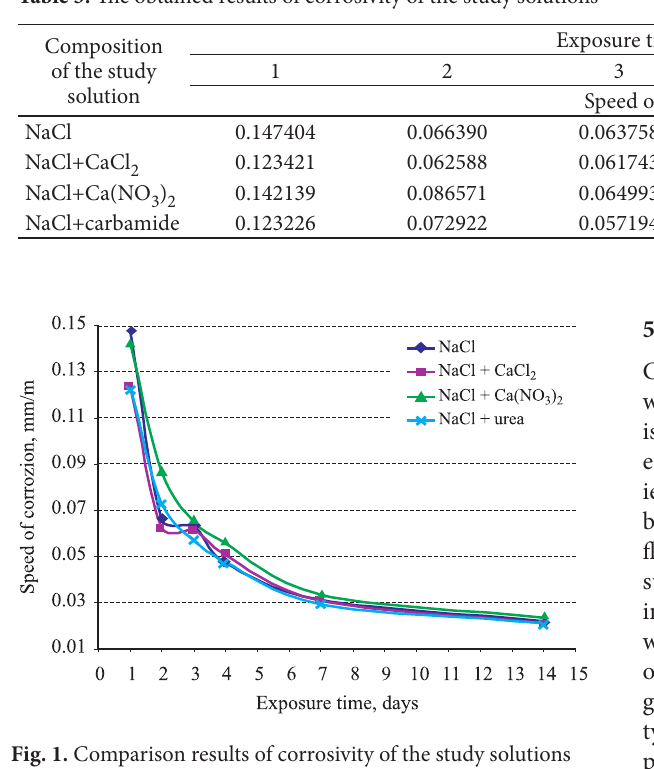
Fig. 1. Comparison results of corrosivity of the study